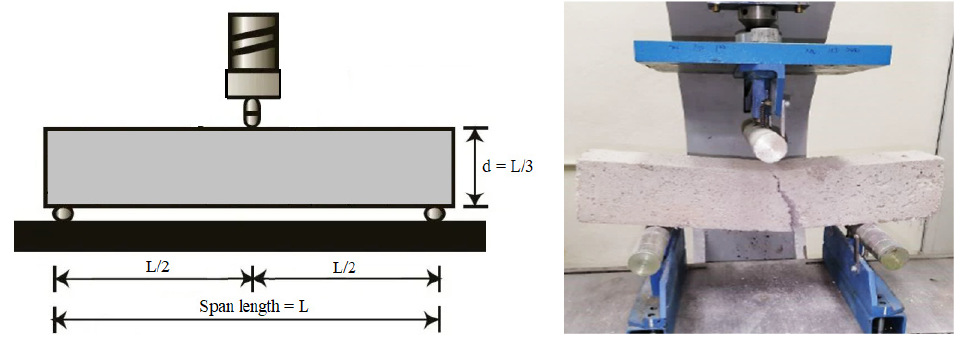
Figure 5. Apparatus for three-point bending test.